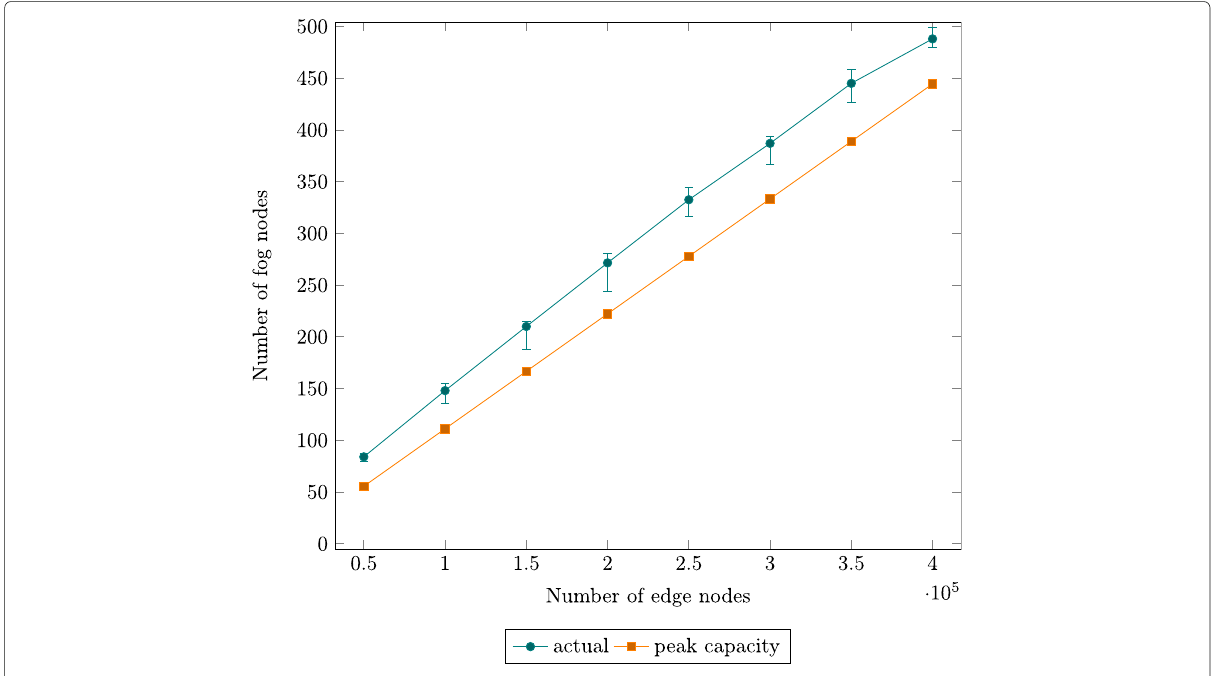
Fig. 9 Number of fog nodes activated by varying number of edge nodes